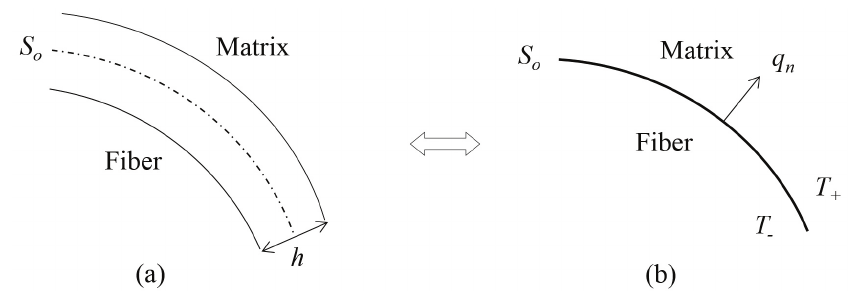
Figure 3. (a) Interphase fiber/matrix and (b) equivalent imperfect